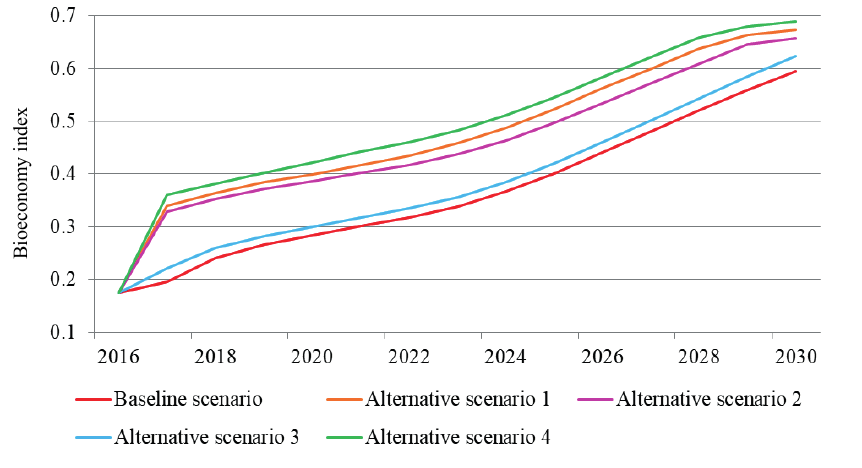
Fig. 7. Bioeconomy index changes for simulated scenarios